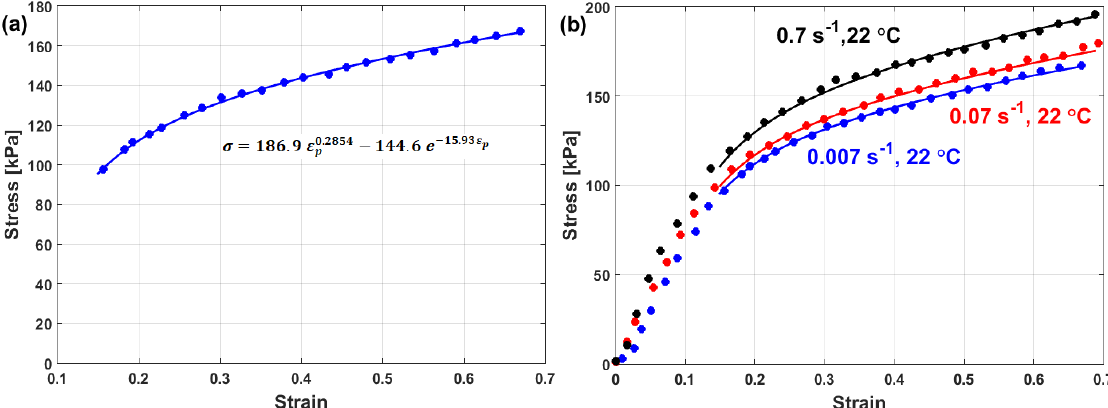
Figure 45. ( a ) Fitting true stress true strain to obtain constants 𝐴 1 , 𝑛,𝐴 2 , and 𝐾 at reference values and (b) comparison between experimental stresses (markers) and predicted stresses (solid line) for ballistic Roma Plastilina NO. 1 clay obtained using the modified JC model that was introduced by Li et al. [92].